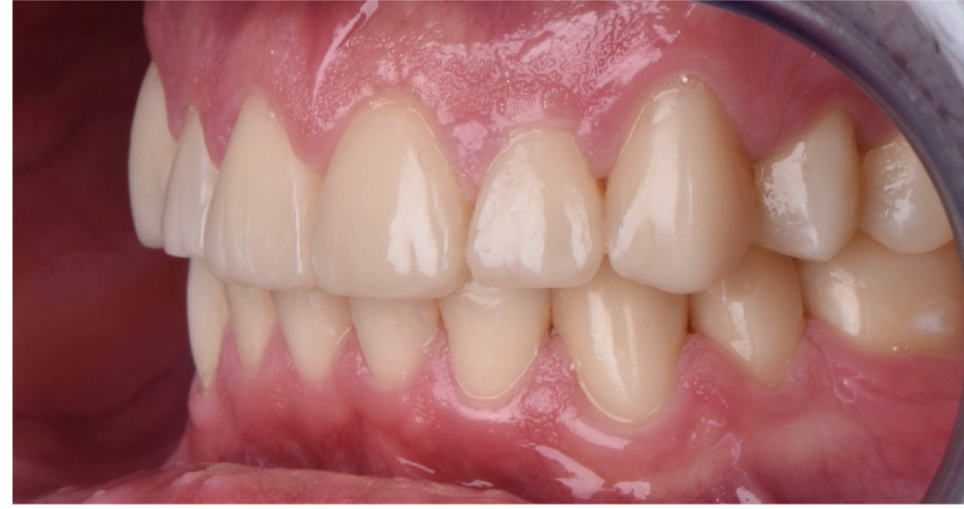
Figure 32. Final intraoral picture (left).